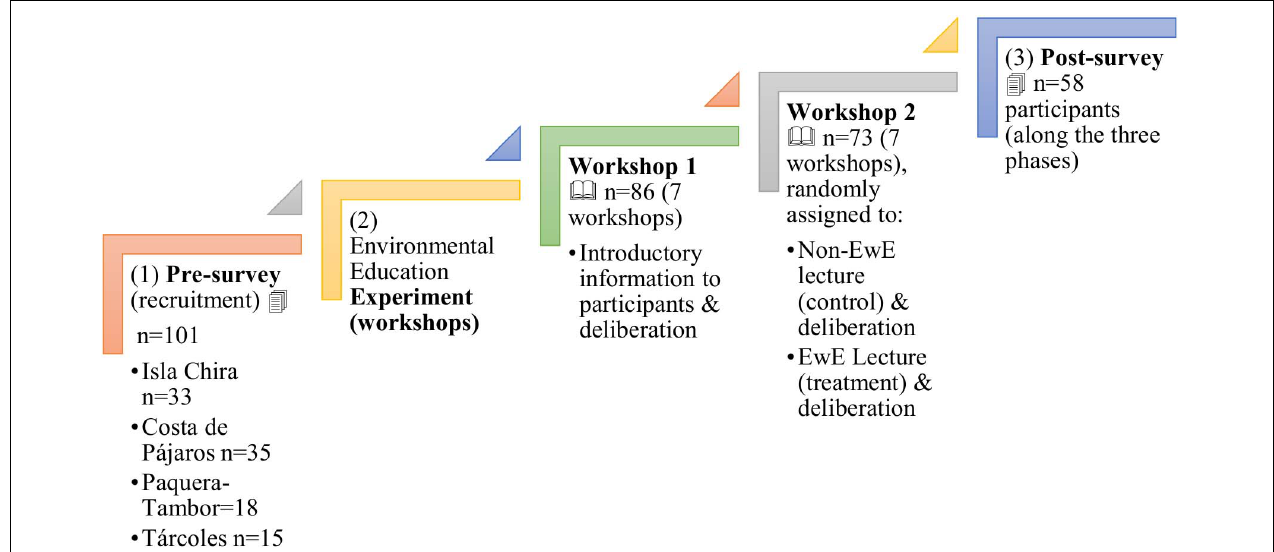
FIGURE 4 | Experimental design applied with small-scale gillnet fishers in Gulf of Nicoya; 58 were the number of fishers who participated in the three phases of the study (pre, workshop, and